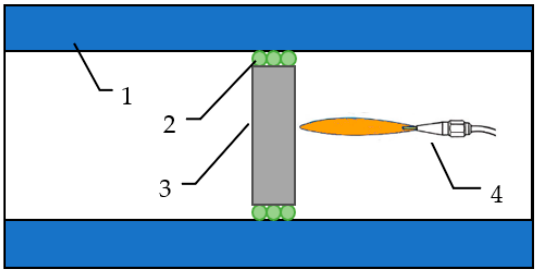
Figure 4. Scheme of the measuring system showing the mini fire-jet test: (1) thermal chamber; (2) high-temperature insulation material; (3) sample; (4) fire-jet system.